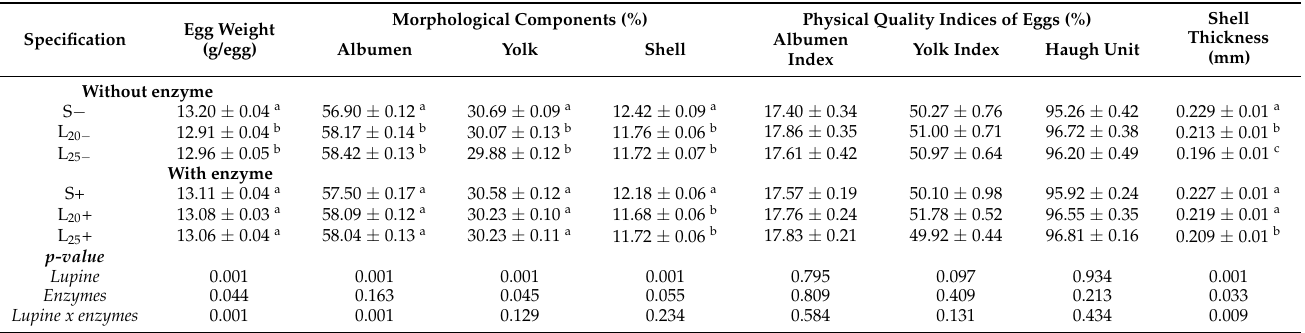
Table 6. Influence of enzymes addition in lupine-based diets on the physical quality indices of fresh eggs (mean ± std. error).